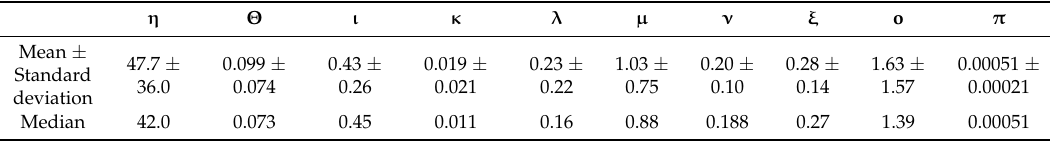
Table 2. Posterior distributions of parameters ( η , θ , ι , κ , λ , µ , ν , ξ , o, and π ) in Equations (2)–(4) (Ln( flux